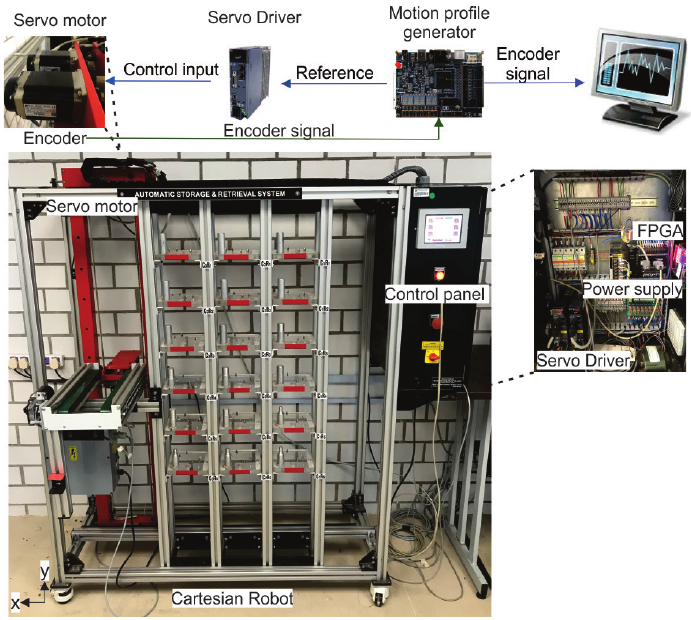
Figure 8. Experimental